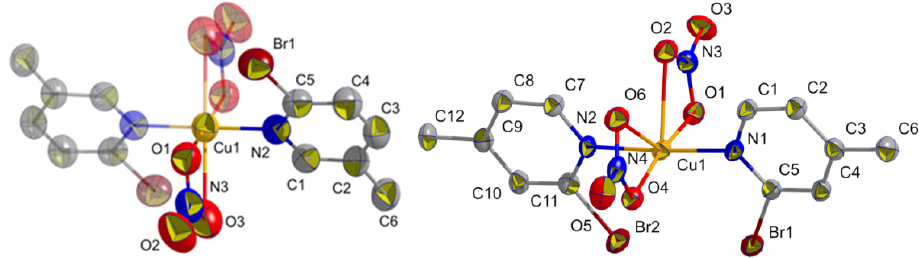
Figure 3. The asymmetric unit of the two isomers of [Cu(L) 2 (NO 3 ) 2 ] with atom numbering. ( left ): CuL 1 , L 1 = 2 ‐ bromo ‐ 5 ‐ methylpyridine in P 2 1 /c; ( right ): CuL 2 , L 2 = 2 ‐ bromo ‐ 4 ‐ methylpyridine in P 1 (cid:3364) . ( left ): CuL 1 , L 1 = 2-bromo-5-methylpyridine in P 2 2 , L 2 = 2-bromo-4-methylpyridine in P 1 /c; ( right ): CuL